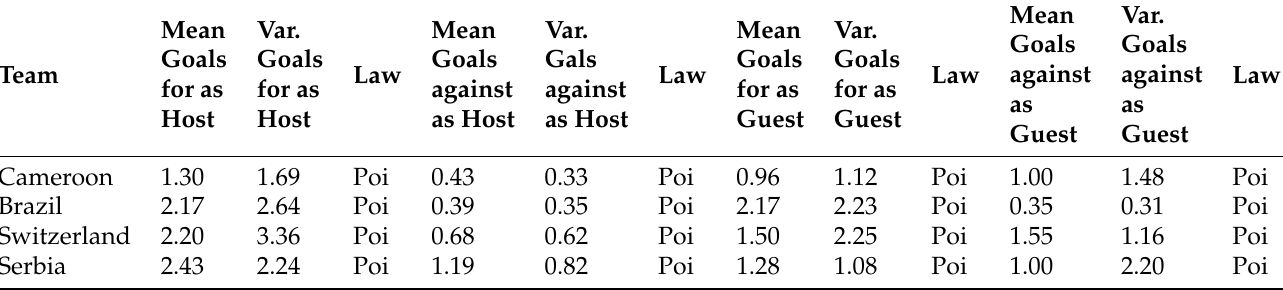
Table 25. Group G in Qatar 2022.